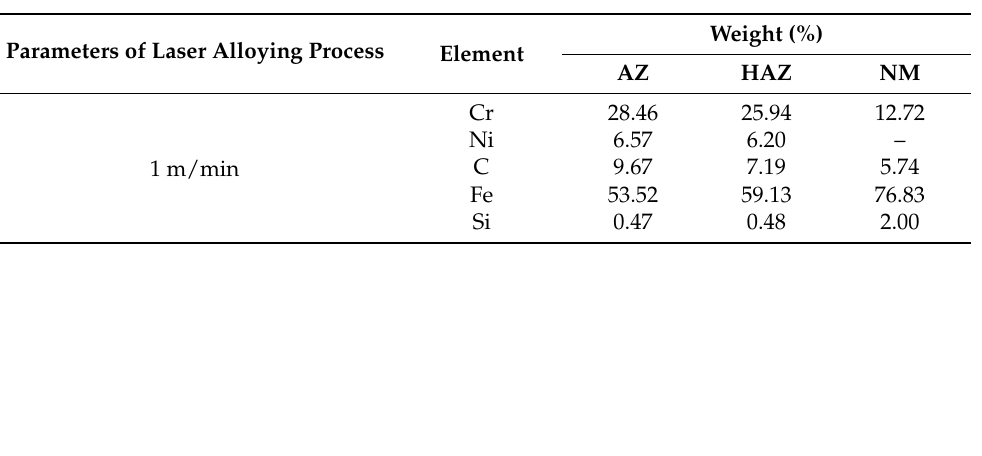
EDX–analysis after laser alloying (AZ—alloying zone, HAZ—heat-affected zone, NM—native material) for sample